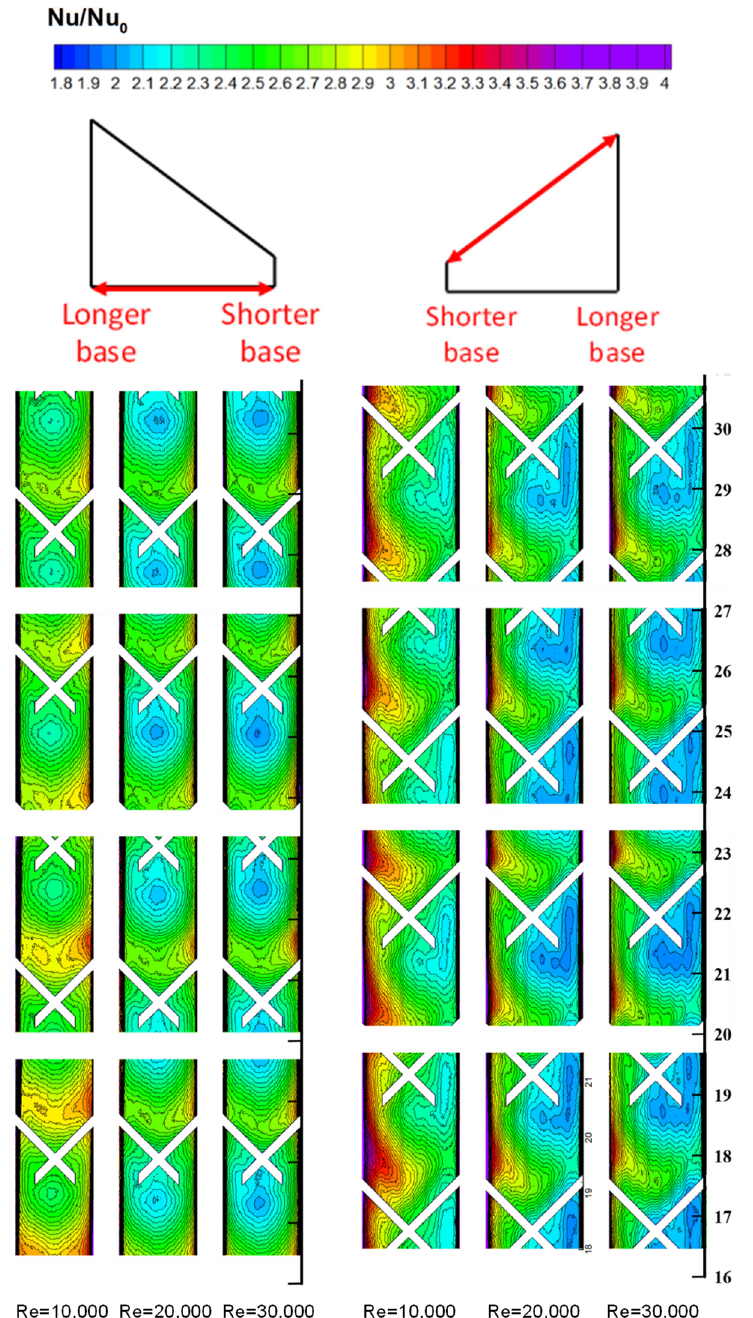
Figure 8. Nusselt number ratios for the upstream cutback X-shaped rib ( P/e = 20).